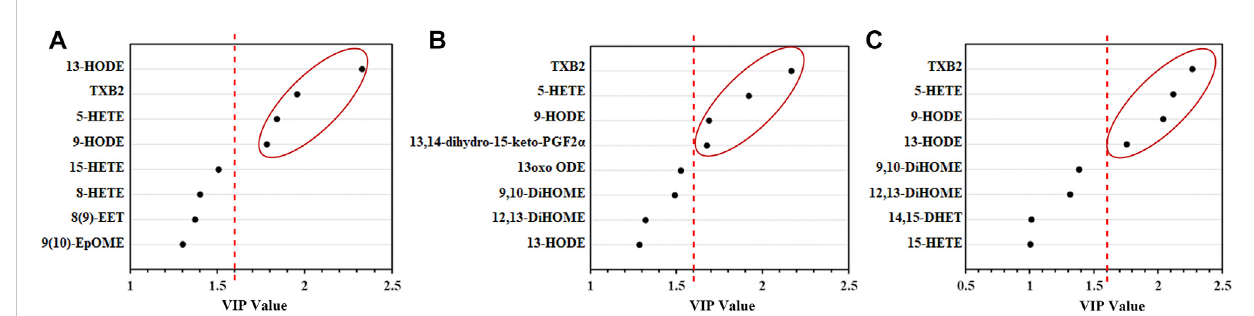
Results of PLS-DA analysis of lung tissue, the right side of the red-dashed line shows the difference LMs with VIP values > 1.6. (A) High-dose group (B) . Medium-dose group (C) . Low-dose group. n =